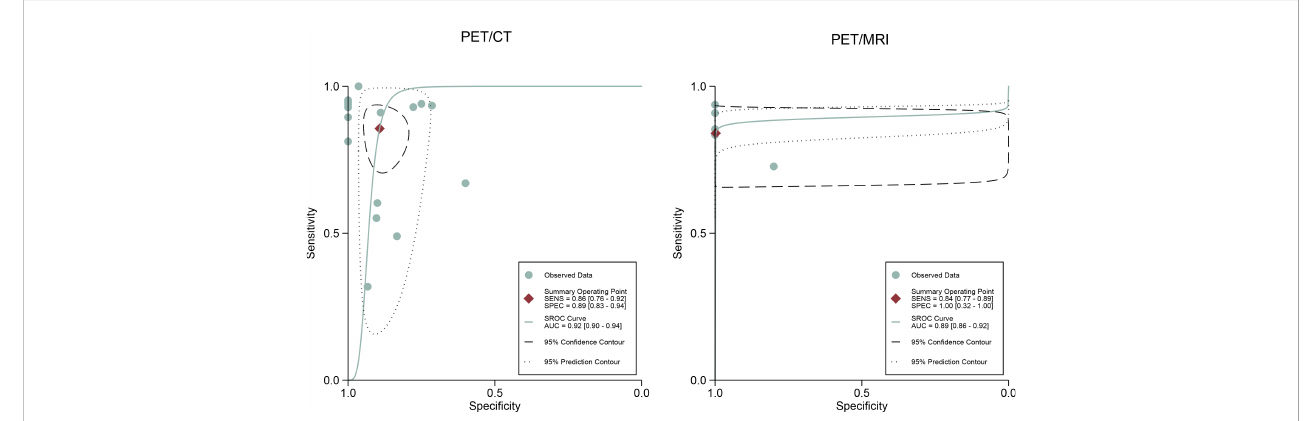
FIGURE 5 [18F]FDG PET/CT and [18F]FDG PET/MRI summary receiver operating characteristic (SROC) curves. The summary point is the optimal combination of sensitivity and speci fi city. The black dotted lines surrounding each summary point indicates the 95% con fi dence interval.